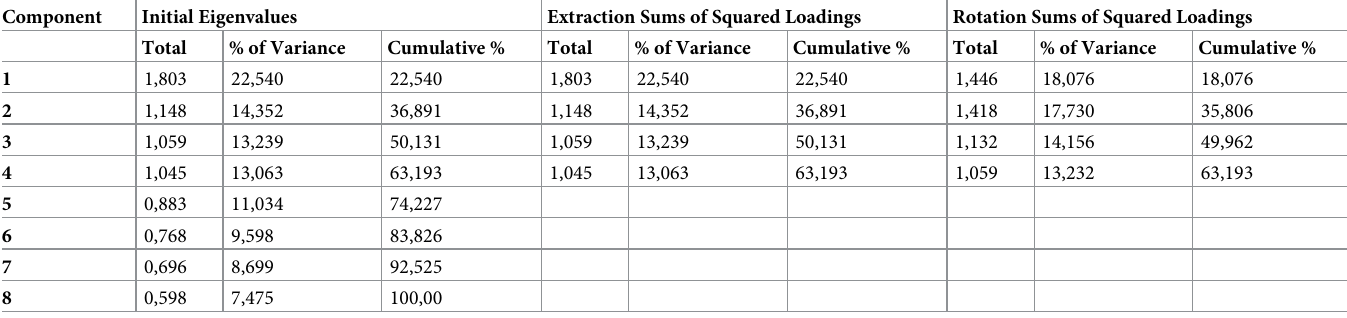
Table 6. Total variance explained (students participating in the DLGs).